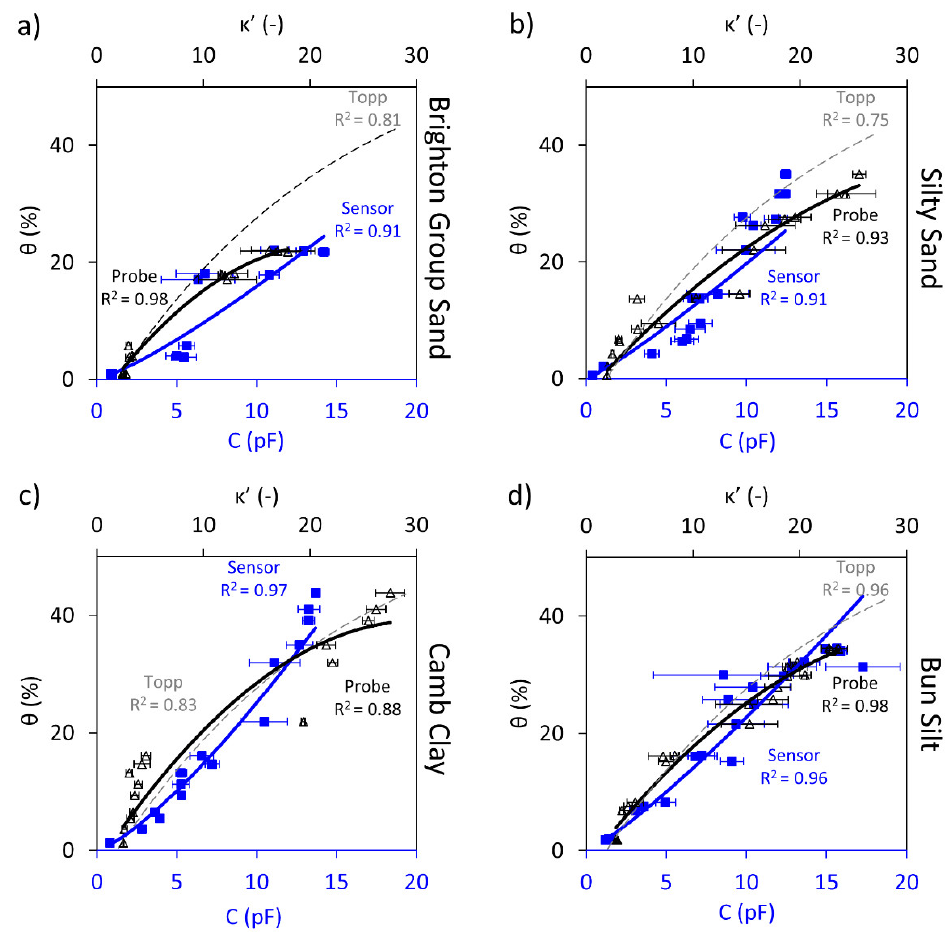
Figure 7. AOGAN sensor capacitance, C, readings (blue square markers and trendline) and dielectric constant, κ ’, measurements (black triangular markers and trendline) shown against the volumetric water content, θ ; the Topp equation is also shown (dashed grey trendline). Shown for: ( a ) Brighton Group Sand ( b ) Silty Sand ( c ) Camb Clay and ( d ) Bun Silt.